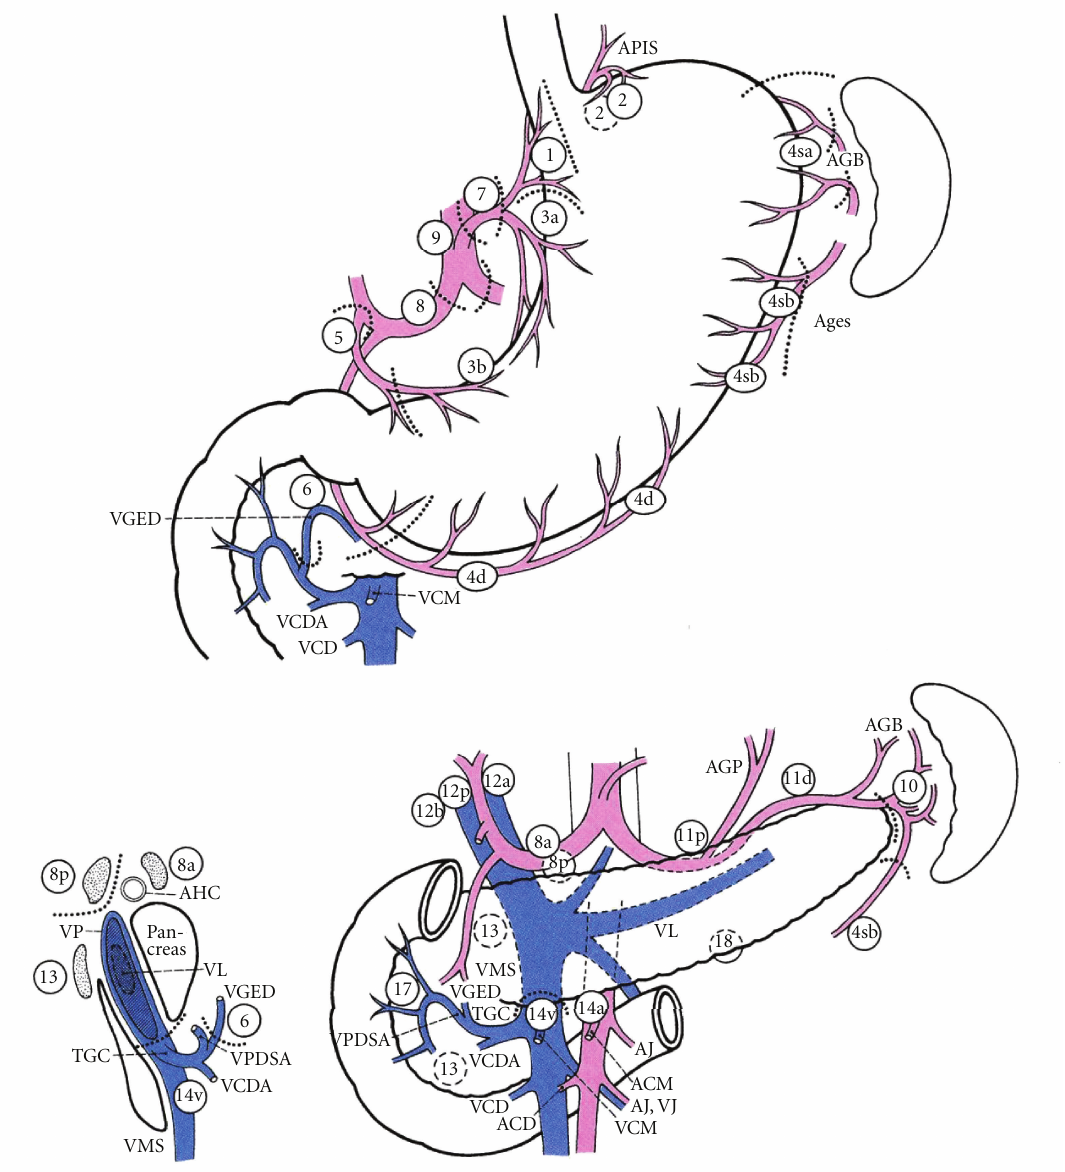
Figure 1: Lymph noses (LNs) are retrieved from the en bloc resected specimen and placed on the map exactly as they were in situ and numbered. Regional lymph node stations are defined as No. 1, right paracardial LN; No. 2, left paracardial; No. 3, LN along the lesser curvature; No. 4sa, LN along the short gastric vessels; No. 4sb, LN along the left gastroepiploic vessels; No. 4d, LN along the right gastroepiploic vessels; No. 5, suprapyloric LN; No. 6, infrapyloric LN; No. 7, LN along the left gastric artery; No. 8a LN along the common hepatic artery; No. 9, LN around the celiac artery; No. 10 LN at the splenic hilum; No. 11p, LN along the proximal splenic artery; No. 11d, LN along the distal splenic artery; No. 12a, LN in the hepatoduodenal ligament; No. 13, LN on the posterior surface of the pancreatic head; No. 14v, LN along the superior mesenteric vein; No. 16, LN around the abdominal aorta. APIS, left inferior phrenic artery; GB, short gastric artery; AGES, left gastroepiploic artery; VCM, middle colic vein; VGED, right gastroepiploic vein; VCDA, accessory right colic vein; VCD, right colic vein; AGP, posterior gastric artery; VL, splenic vein; AJ, jejunal artery; VJ, jejunal vein; ACM, middle colic artery; ACD, right colic artery; TGC, gastrocolic trunk; VMS, superior mesenteric vein; VPDIA, anterior inferior pancreaticoduodenal vein; AHC, common hepatic artery; VP, portal